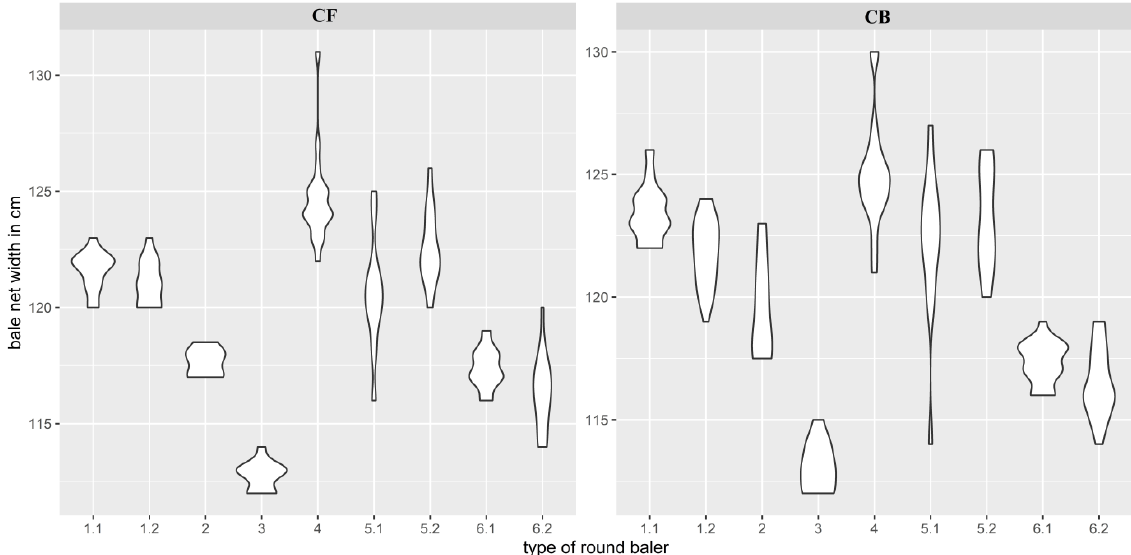
Figure 1. Cover the bales with COVERNET (Tama LT) on the front and back of the bale. 1.1—Sipma Z-569/1 Farma II—dried green fodder; 1.2—Sipma Z-569/1 Farma II—spring barley straw; 2—UNIA DF 1,7 Zd—dried green fodder; 3—UNIA DF 1,8 Dd—dried green fodder; 4—Sipma PS 1211 FARMA PLUS—winter triticale straw; 5.1—Warfama Z-543—spring barley straw; 5.2—Warfama Z-543—winter wheat straw; 6.1—Metal-Fach Z-562—winter rye straw; 6.2—Metal-Fach Z-562—winter wheat straw.